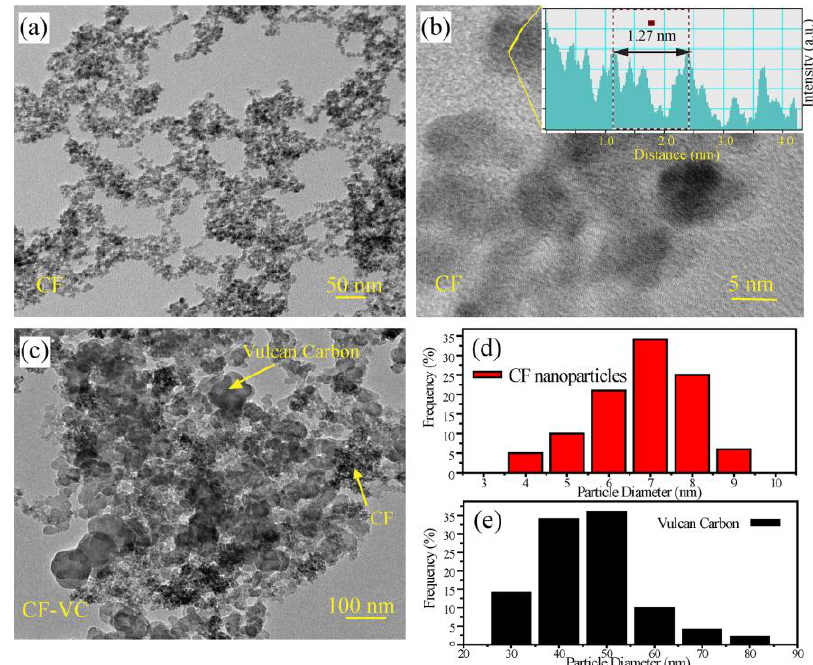
Figure 1. ( a , b ) Transmission electron microscopy (TEM) images of the cobalt ferrite (CF) nanoparticles at different magnification. The inset in (b) shows a line profile corresponding to the (311) plane of the cobalt ferrite. ( c ) TEM image of the CF-VC catalyst showing the size and distribution of the CF and Vulcan carbon. ( d , e ) Particle size distribution analysis of the CF-VC catalyst showing CF and Vulcan carbon, respectively.